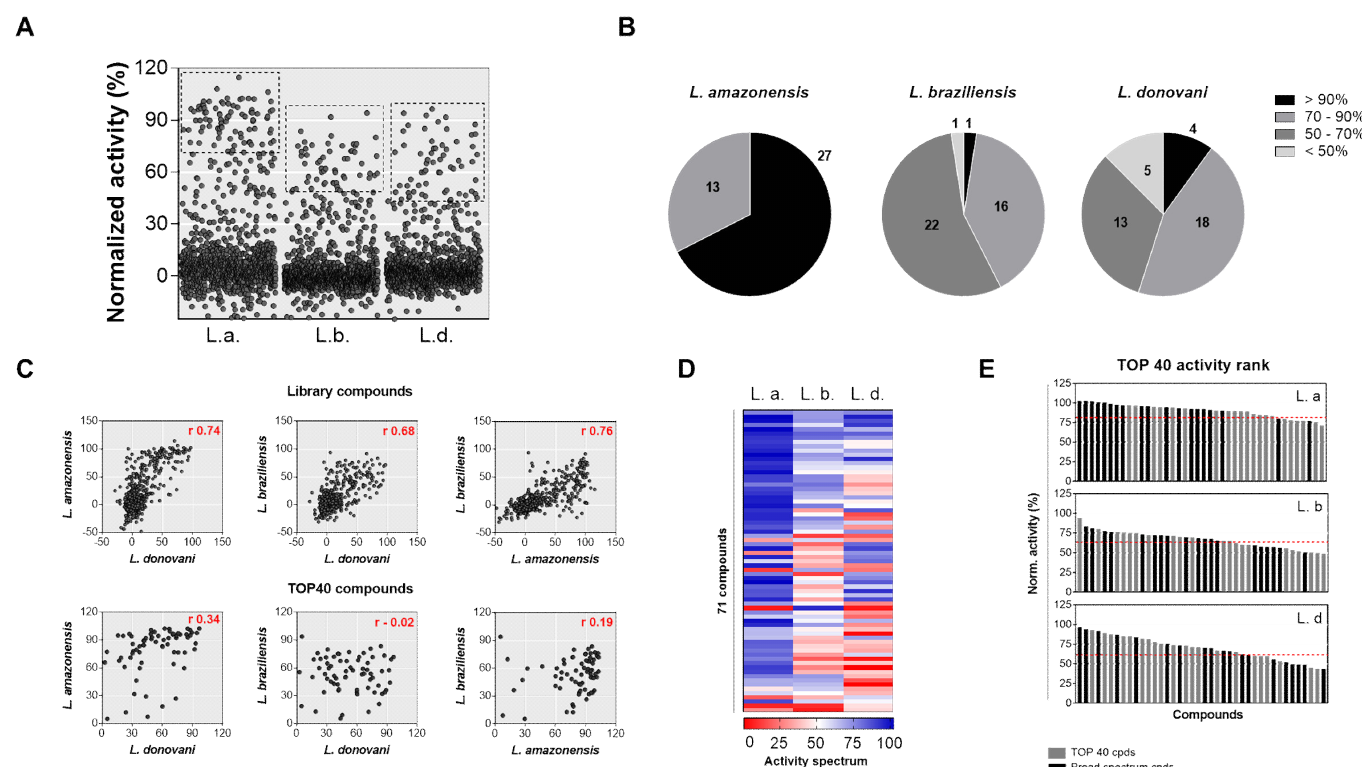
Figure 3. Primary screening of diversity-based library against Leishmania species panel. A library containing 1280 pharmacologically active molecules was screened at 50 µM against L. donovani , L. braziliensis , and L. amazonensis in two independent experiments. ( A ) Distribution of the whole library compounds per normalized activity. Data represent the mean normalized activity of each well from two independent experiments. The forty compounds that presented the highest activity and were nontoxic to human macrophages were selected as “top 40” and are contained in the dotted square. ( B ) Pie charts representing the distribution of the top 40 compounds per normalized activity for Leishmania species. The values inside the graphs represent the number of compounds. ( C ) Correlation of compound activity between the species in pairs, in terms of library compounds (top) and “top 40” compounds (bottom). The mean normalized activity from two independent experiments is plotted. Spearman rank correlation coefficients are shown in the right top corner of the graphs. ( D ) Heatmap of compound activity on Leishmania species infection. The color scale illustrates normalized activity in relation to controls: zero activity (red), 50% activity (blank), and 100% activity (blue). ( E ) Activity rank of top 40 compounds, for each Leishmania model: broad spectrum compounds (black) and top 40 compounds (grey).